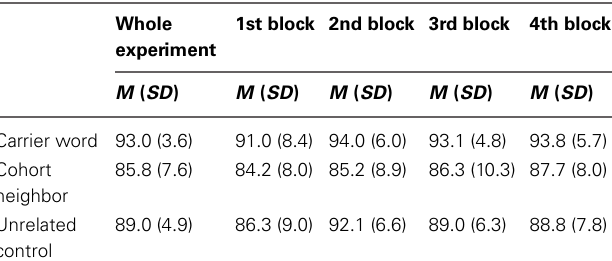
Table 2 | Mean correct responses in percent (with standard deviation) collapsed across all blocks (with four repetitions per target word); and separately for the first presentation (first block), first repetition (second block), second repetition (third block), and third repetition (fourth block) of the